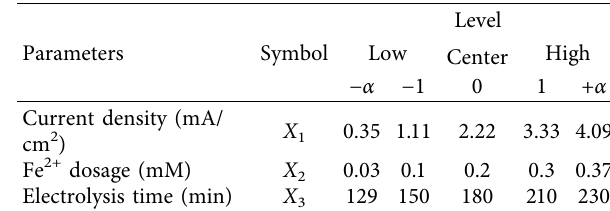
Table 1: Factors and their levels used for experiments by the CCD.